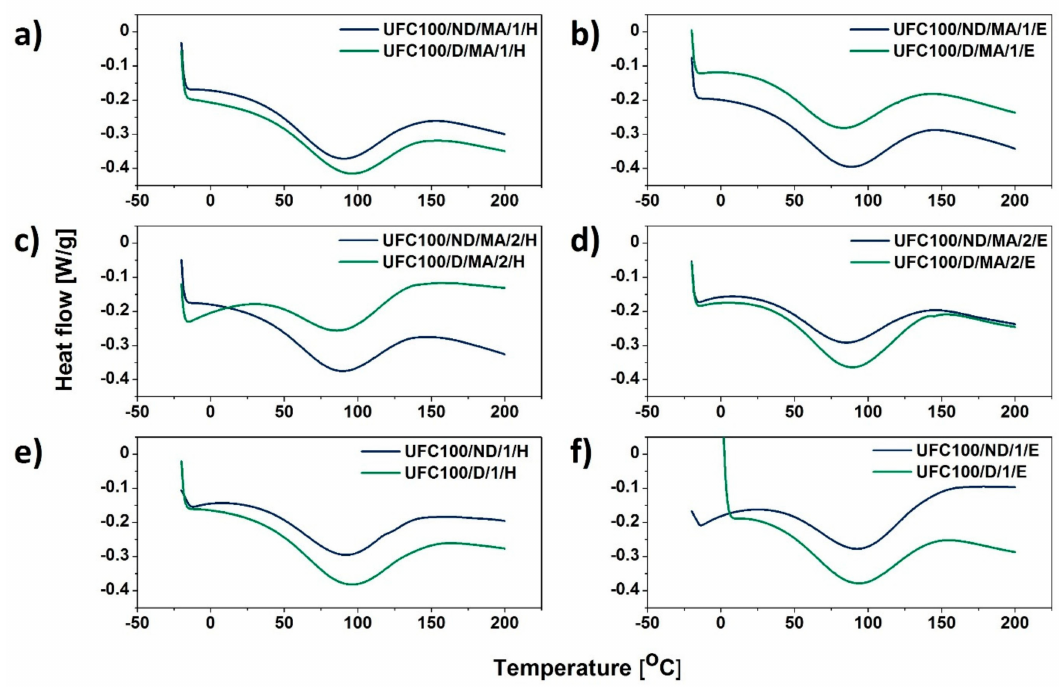
Figure 11. DSC curves of cellulose samples modified via a hybrid chemical approach and